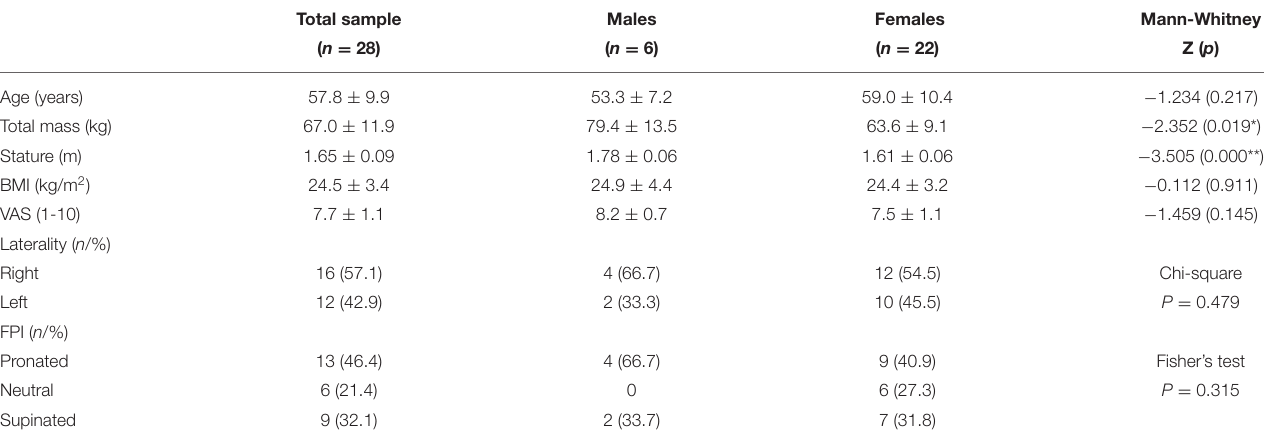
TABLE 1 | Anthropometric and clinical characteristics of the sample. Total sample Males Females Mann-Whitney